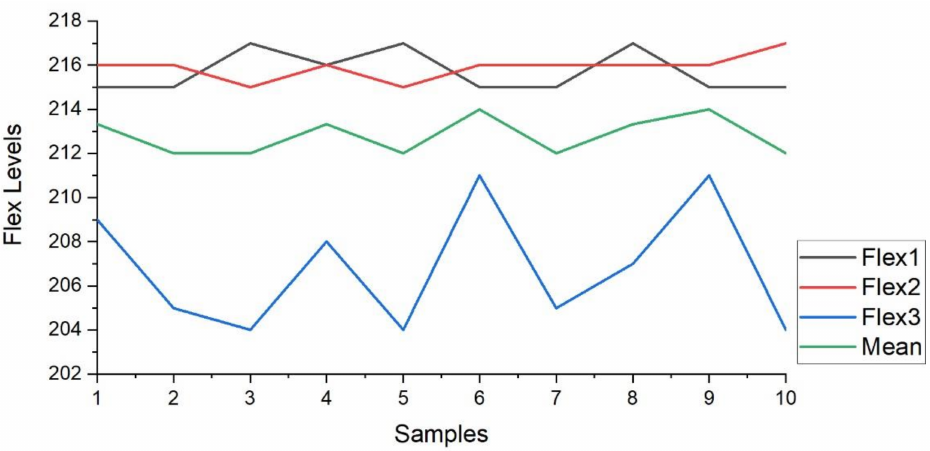
Figure 13. Value variations for samples in June 2020.